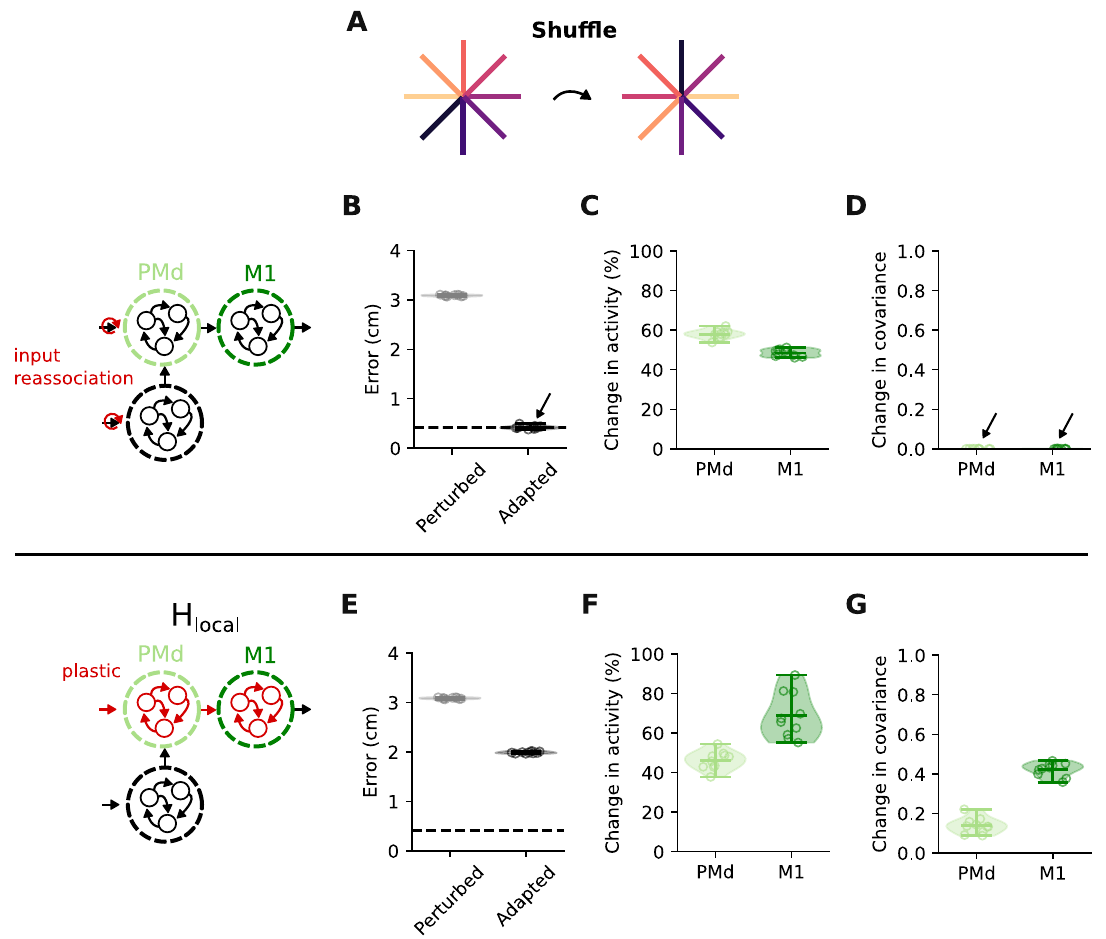
Fig.8|AvisuomotorreassociationtaskcanclearlydifferentiatebetweenH local and learning through reassociation of input signals. A We simulated a task in which the network had to learn new associations between target locations and reach directions ( “ Reassociation''). B Root meansquarederror between target and produced hand trajectories without (grey) and with learning (black) through input reassociation. Dashed line indicates error during baseline trial. Shaded area and horizontal bars, data distribution with mean and extrema ( n =10 network